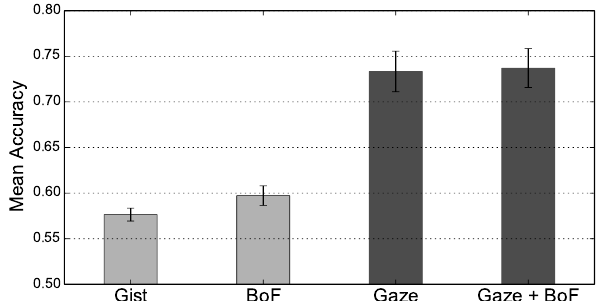
Figure 3 . Comparison between gaze-based and image-based classifiers. The first and second graphs show the mean accu- racies using two image features, GIST and BoF, respectively. The third graph corresponds to the gaze-based classifier, and the fourth graph shows the mean accuracy of a classifier us- ing a combined image and gaze